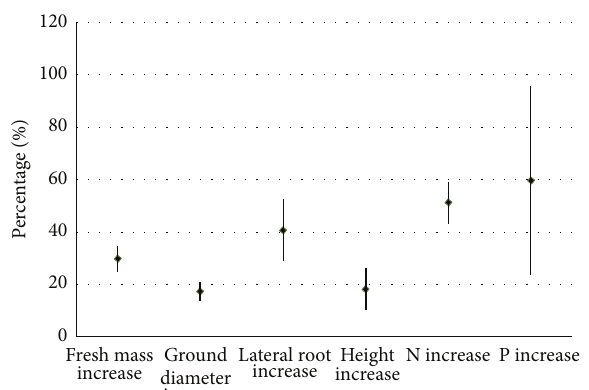
Figure 7: ECM infection influences on plant growth and biomass N, P absorption [39]. The ECM is the same species, Gomphidius viscidus , used in this study, and plant species are Larix kaempferi , Pinus tabulaeformis , and Quercus liaotungensis . The percentage in 𝑦 -axis is the improvement of each parameter relative to the untreated control (without ECM